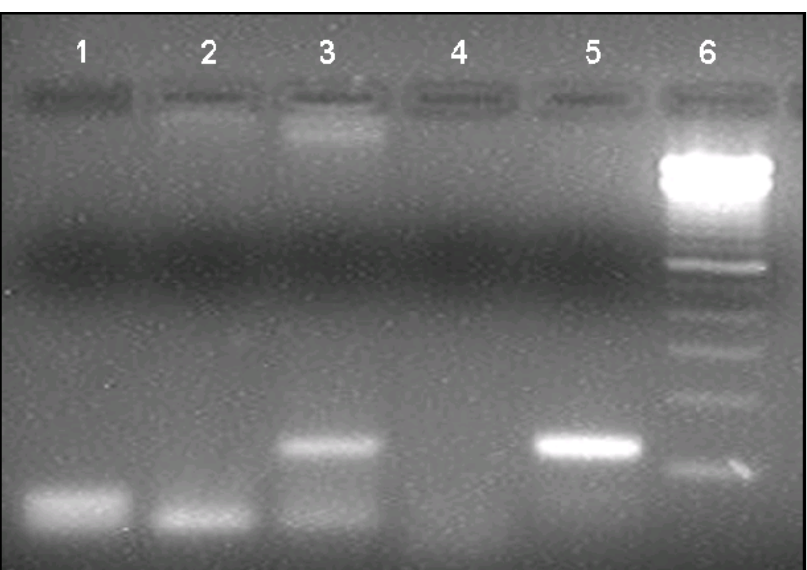
Figure 2. Electrophoresis in 1.5% agarose gel stained with ethidium bromide, showing amplification products (120 bp) from specific Leishmania primers.